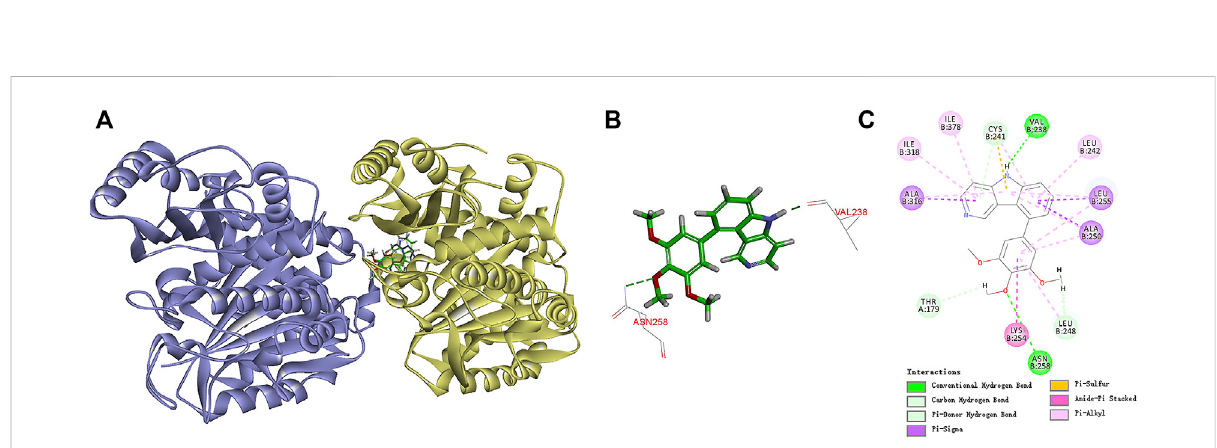
FIGURE 7 (A) Predicted modes for compound 7k (green) and NSC 676693 (grey) binding in the colchicine binding site of tubulin (PDB: 5LYJ); (B,C) Docking conformation of compound 7k in the colchicine binding site of